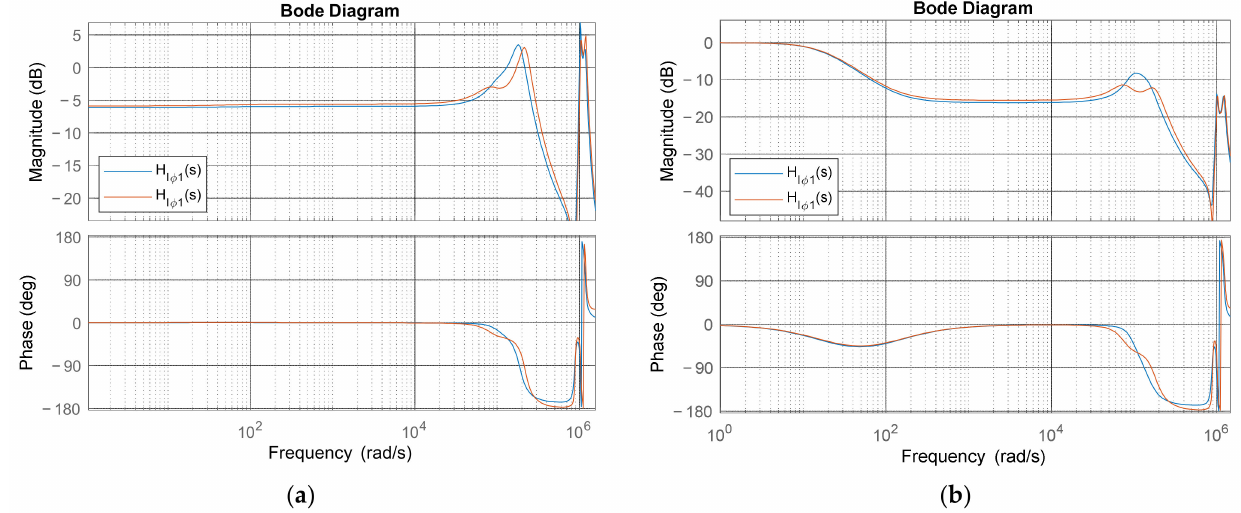
Figure 10. Closed-loop Bode plot of the IPT system using double DD coils and a current controller. ( a ) P controller, ( b ) PI